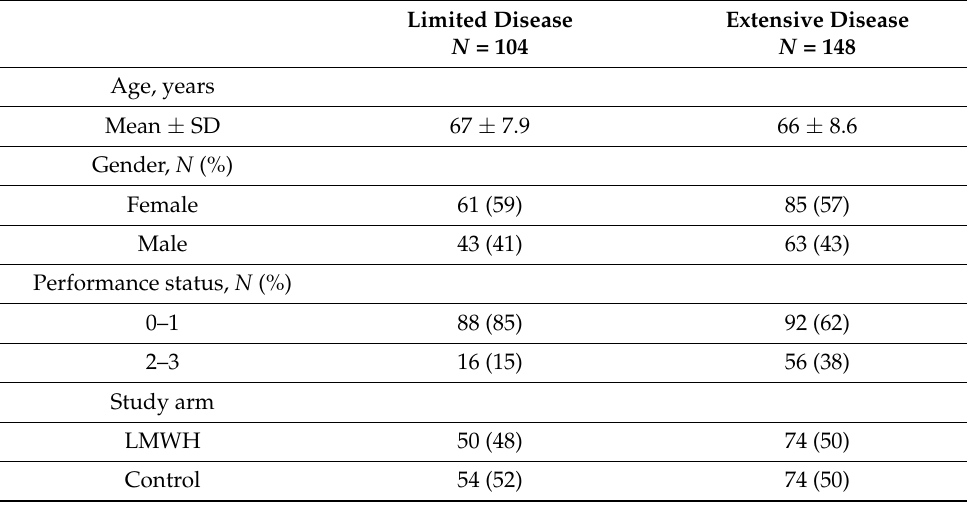
Table 1. Baseline characteristics and treatment summary of the study